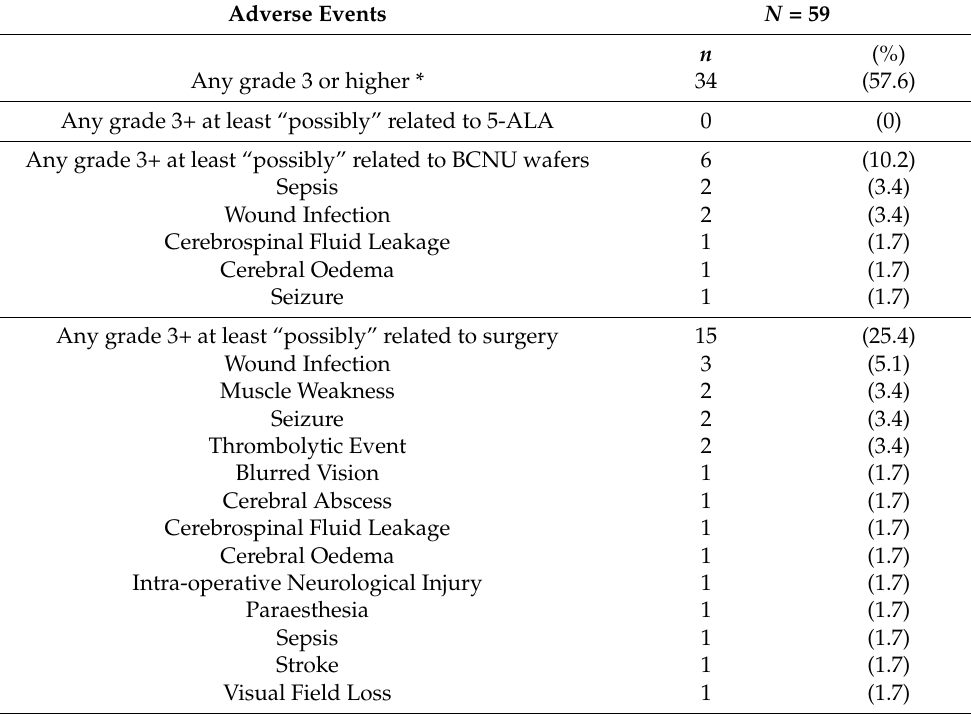
Table 2. Reported grade 3 or higher adverse events—eligible